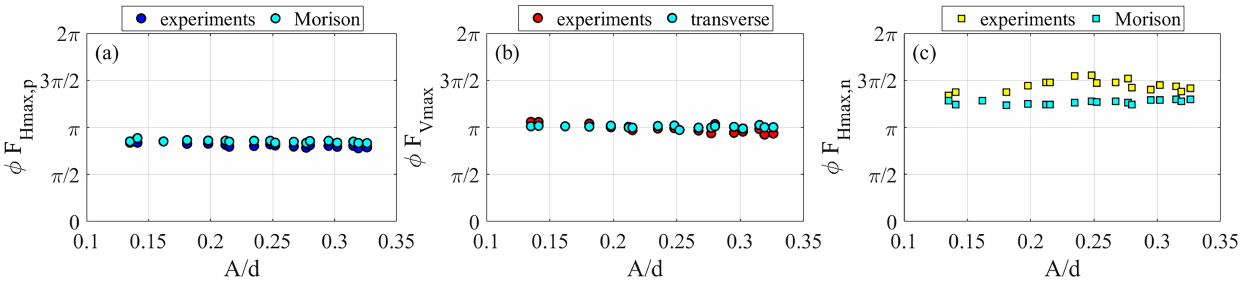
Figure 10. Comparison between experimental and calculated phase shifts related to maximum positive and negative wave forces vs. A / d . ( a ) Phase shift, φ , related to F Hmax , p ; ( b ) phase shift, φ , related to F Vmax ; ( c ) phase shift, φ , related to F Hmax , n